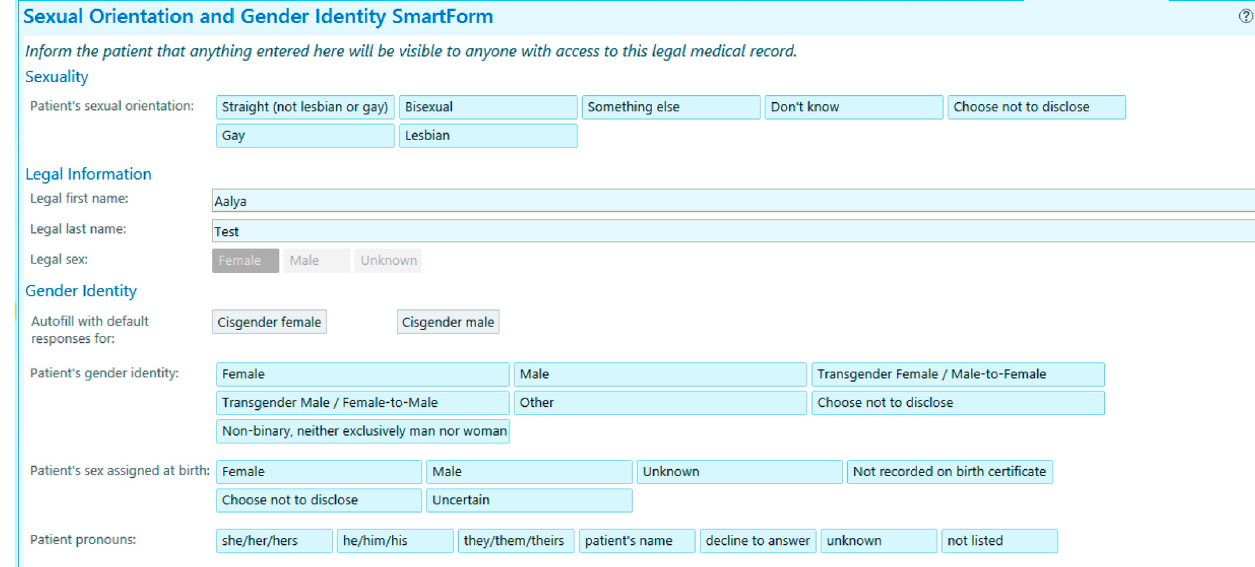
Figure 1. Epic Demographic Sexual Orientation (SO) and Gender Identity (GI) SmartForm (© 2021 Epic Systems Corporation) implemented for SO/GI data collection at Rush University Medical Center in 2020.